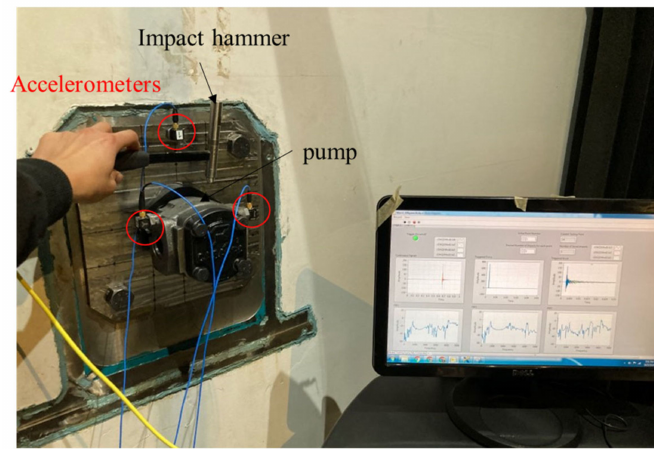
Figure 2. Test setup of experimental modal analysis. Table 1. List of equipment for the impact test.